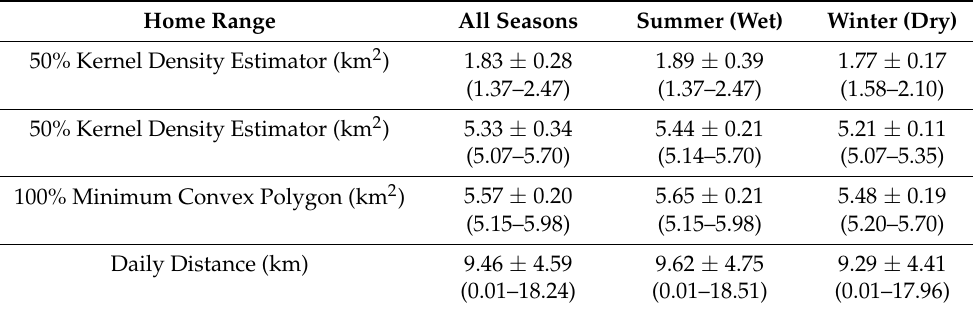
Table 5. Seasonal home range size and movement metrics of lions in the Tula Tsau Conservation Area, South Africa, between 2010 to 2011 (Royal Pride) and 2018 to 2020 (Tsau Pride) (adult males: n = 3; adult females: n = 3; subadult males: n = 4; subadult females: n = 2). Home Range